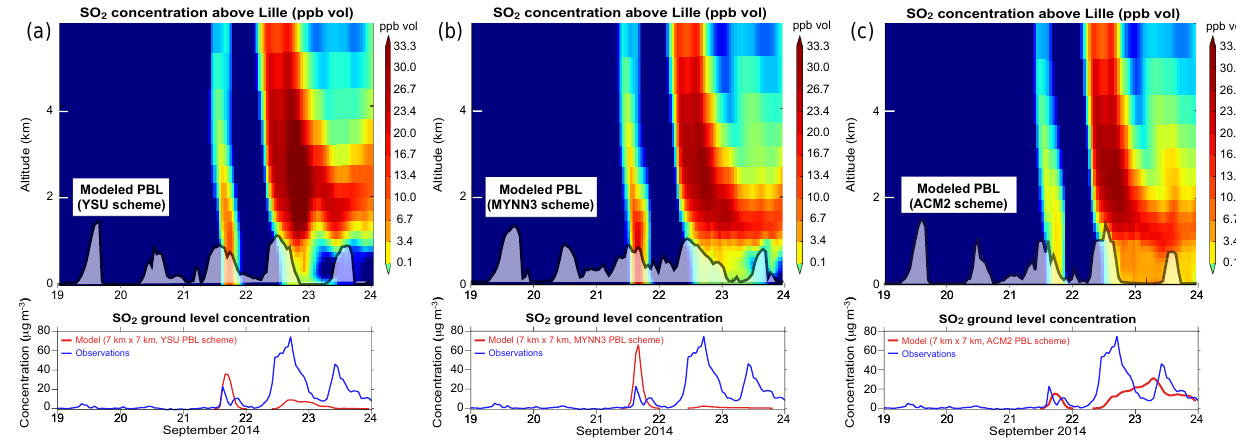
Figure 14. Comparison of far-range vertical distributions of SO 2 over Lille modelled with simulations at high spatial resolution configured with (left) YSU, (middle) MYNN3 and (right) ACM2 parameterization schemes of the planetary boundary layer. (Top) Modelled concentra- tion of volcanic SO 2 as a function of time ( x axis) and altitude ( y axis). The modelled PBL is overlaid in black. (Bottom) Time evolution of the observed (blue) and modelled (red) SO 2 concentrations at